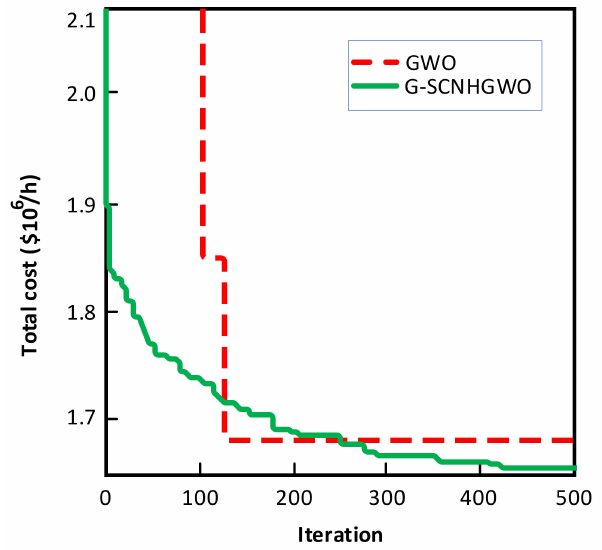
Figure 4. Convergence behavior obtained by GWO and G-SCNHGWO algorithms for Case D. Table 14. Unit’s data for the 40-unit large-scale power